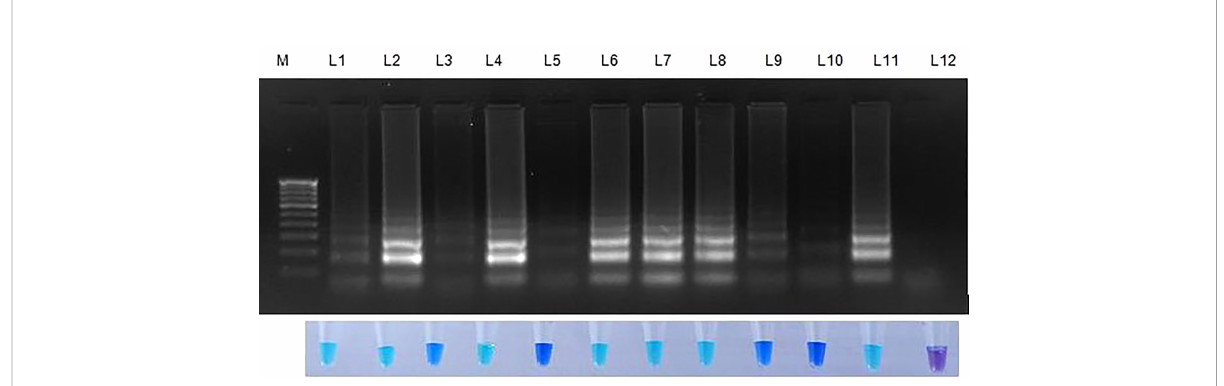
FIGURE 6 Validation of LAMP assay with S. oryzae infected paddy and weed samples. Bright sky blue colour represents positive reaction while the violet colour indicates the negative reaction. Total DNA isolated from fungi was used as the positive control. Upper panel in the fi gure shows agarose gel electrophoresis results whereas lower panel shows reaction tubes for colorimetric detection. M- 100bp Ladder; Lane 1: Oryza sativa ; Lane 2: Echinchloa crusgalli : Lane 3: Cyperus difformis ; Lane 4: Eleusine indica ; Lane 5: Dactyloctenium aegyptium ; Lane 6: Cyperus iris ; Lane 7: